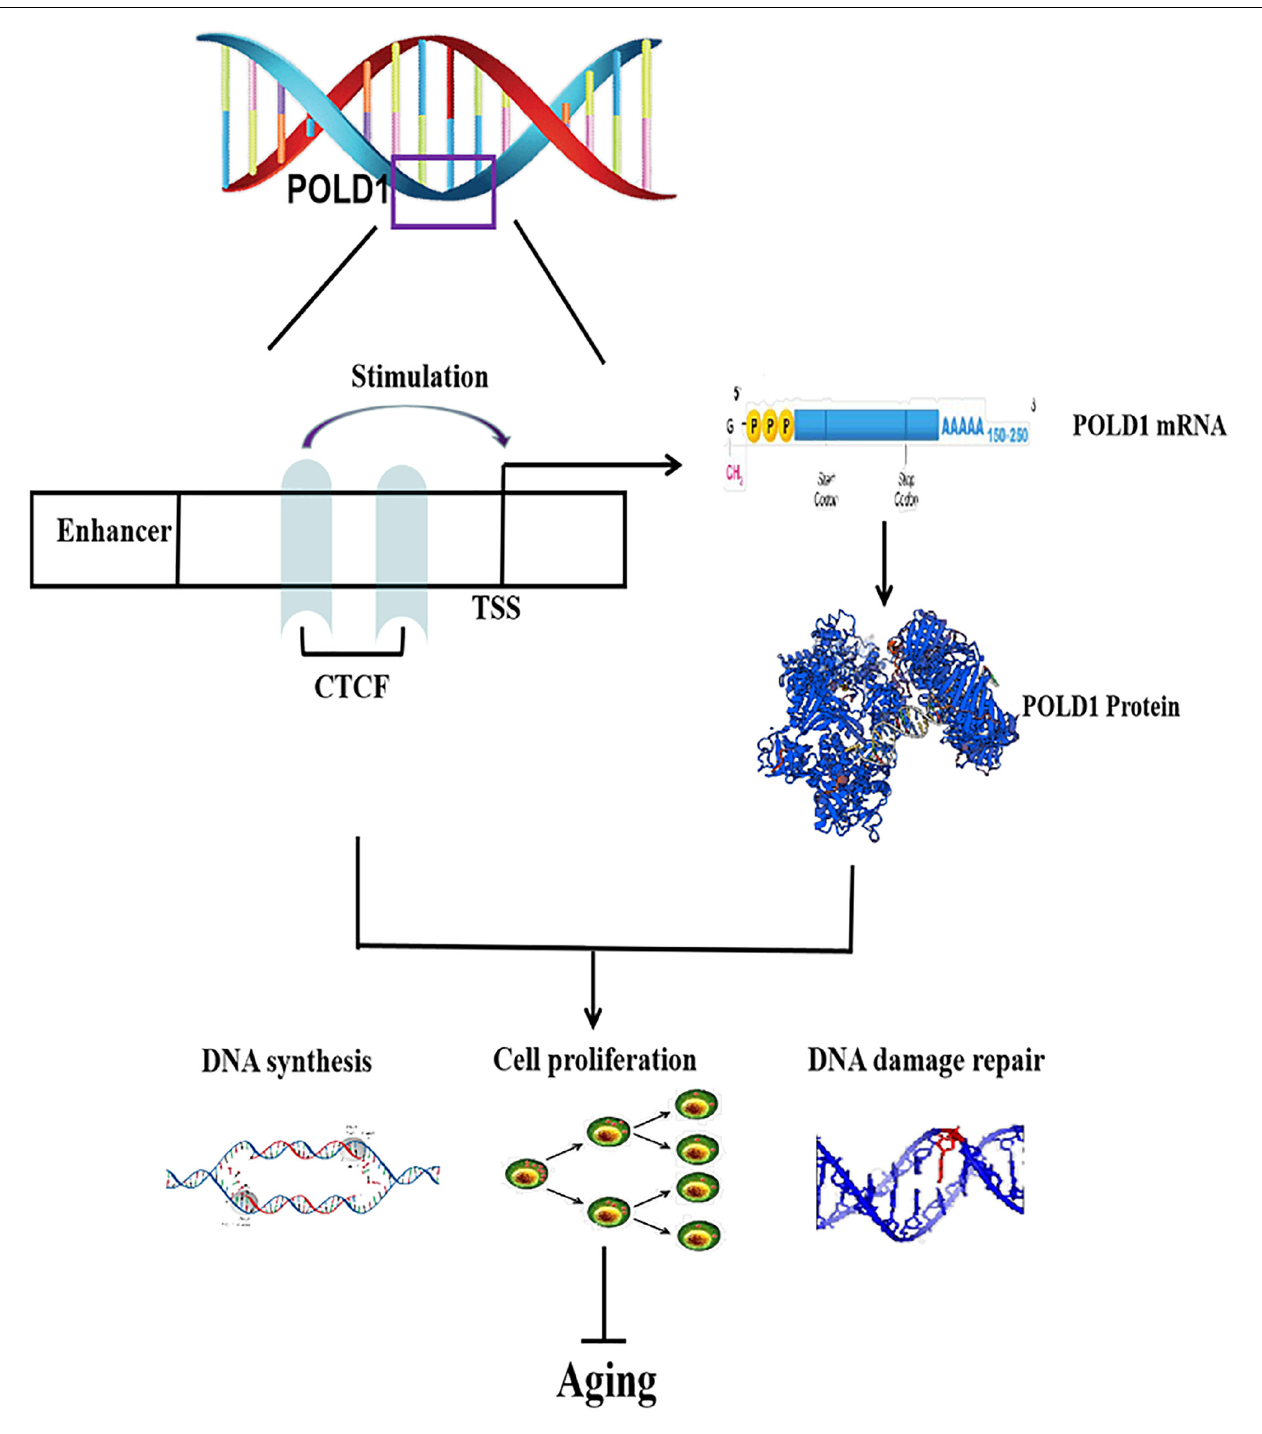
FIGURE 7 | Regulatory mechanism of CCCTC-binding factor (CTCF) on aging. CTCF binds to the DNA polymerase delta 1, catalytic subunit (POLD1) promoter, and stimulates POLD1 expression to inhibit the progression of aging. TSS, transcription start site.